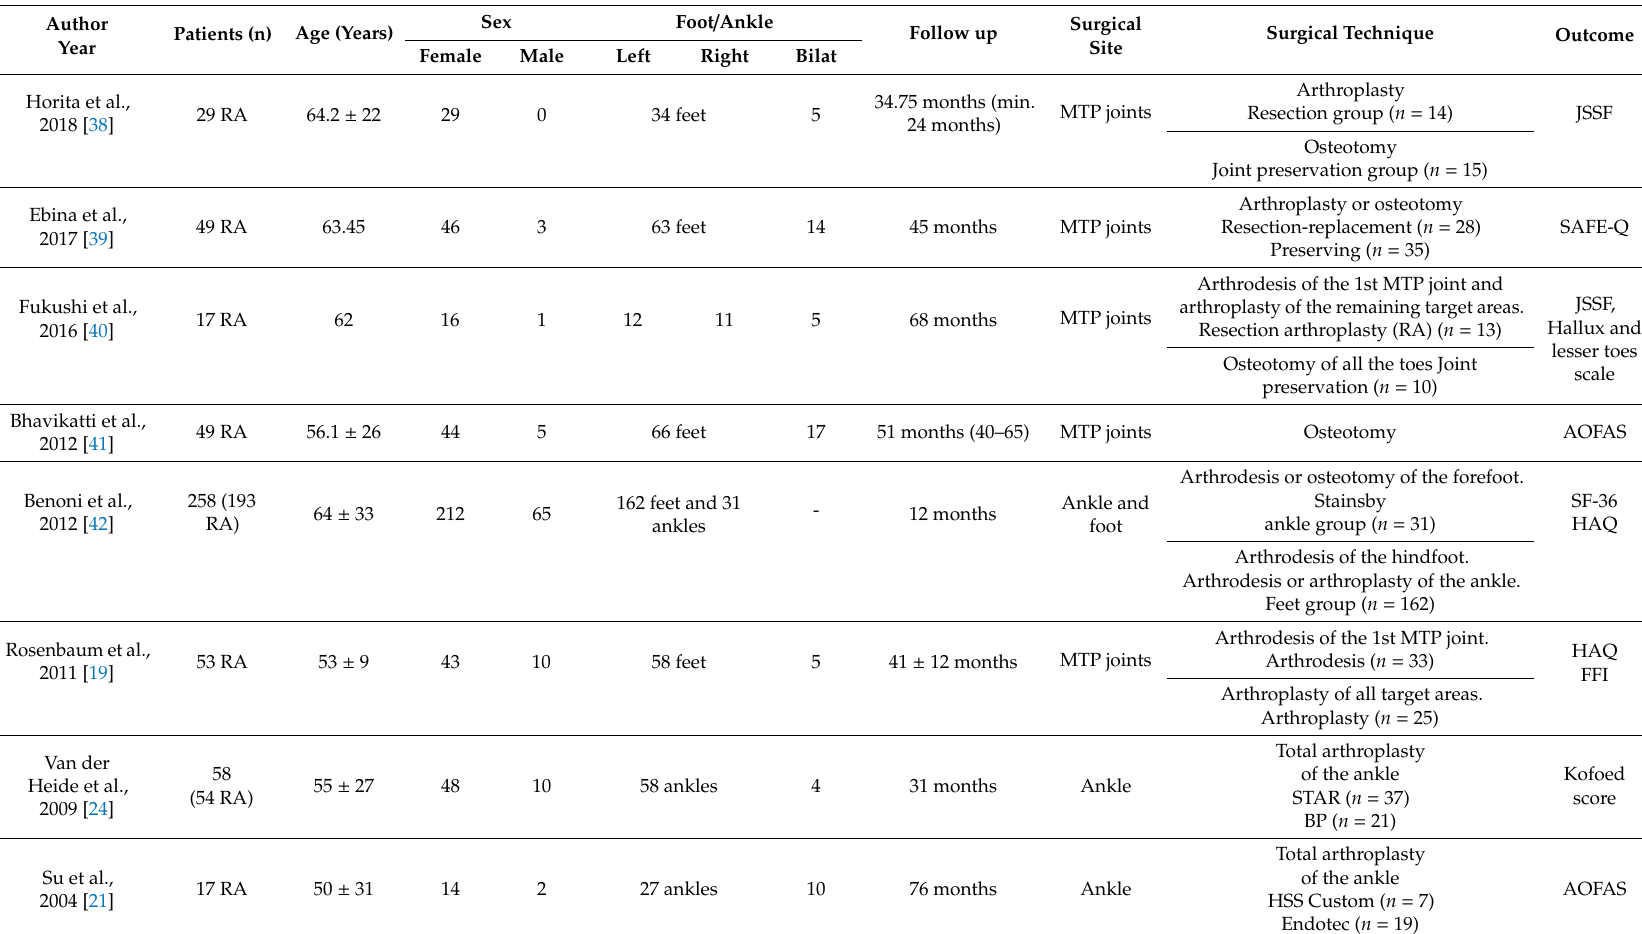
Table 1. Characteristics of Non-Randomized Controlled Trials